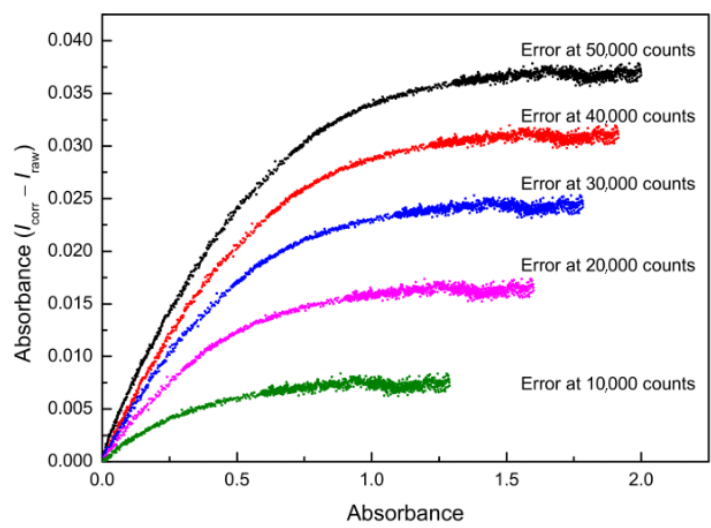
Figure 10. Differences between corrected and referential raw intensities in terms of absorbance error values (Y-axis) at different absorbance levels (X-axis).